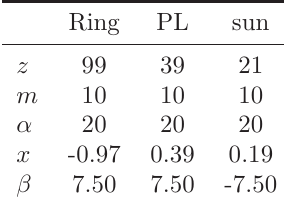
Figure 6: Boundary conditions applied to the FEM. where d = 400 . 4[mm] is the pitch diameter of the planet gears. The basic gear data for the planetary gear is given in Table 3. Table 3: Basic gear data. Length in [mm] and angle in [deg].